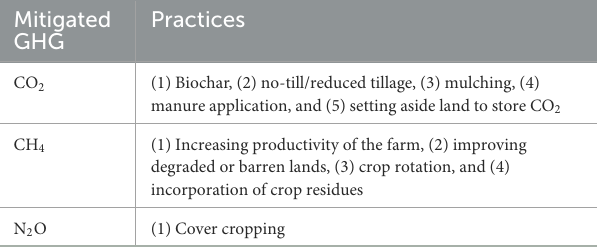
TABLE 1 Sustainable soil management practices for GHG